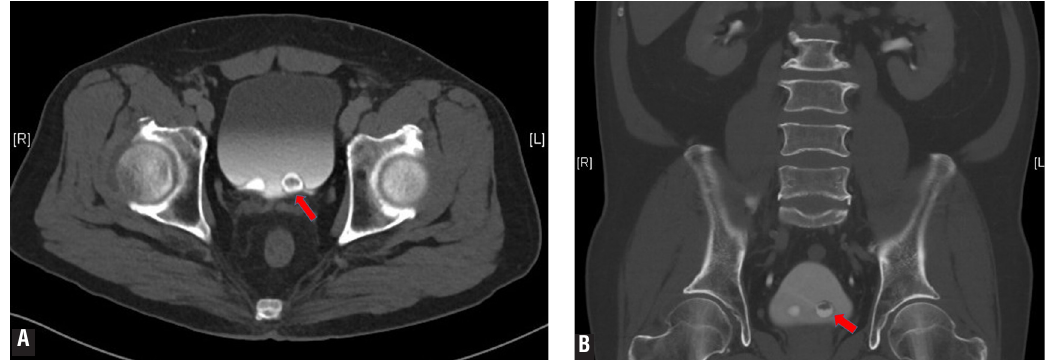
Figure 1 - A and B): CT Urography revealed bilateral simple ureteroceles with the left containing a slightly